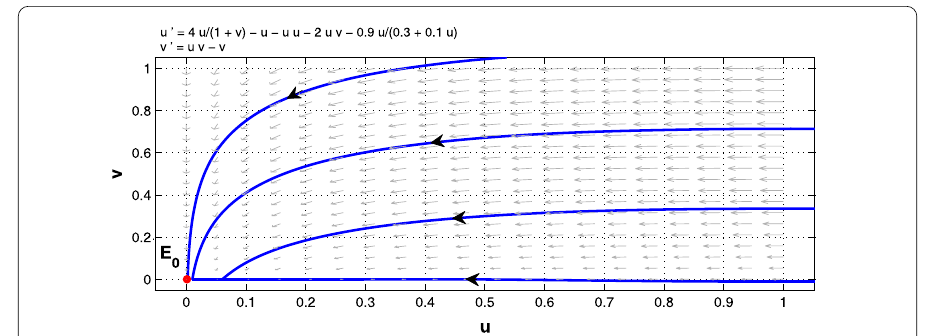
Figure 5 Dynamic behavior of system (5.1) with r 0 = 4, d = 1, k = a = m = 1, c = 0.5, p = 2, m 1 = 1, m 2 = 0.1, q = 3, and E = 0.3